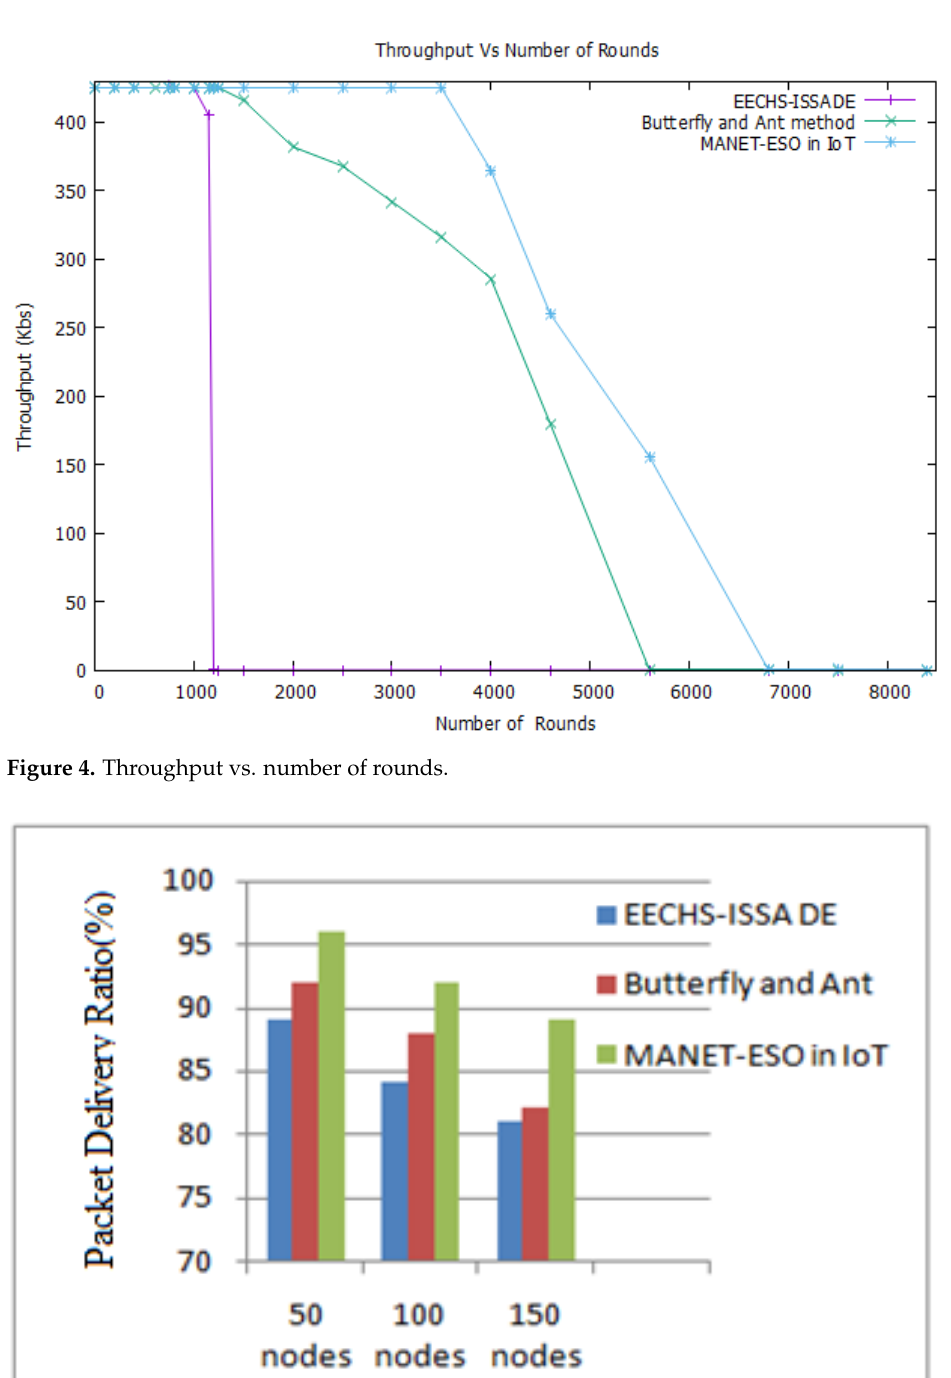
Figure 6. Routing Overhead vs. Number of Nodes. In this Figure 7, the packet delivery ratio of the MANET-ESO in the IoT algorithm is compared with the EECHS-ISSA DE, Butterfly and Ant algorithms with respect to the percentage of malicious nodes. The number of malicious nodes in the network increased by 10 and we observed that PDR improved.